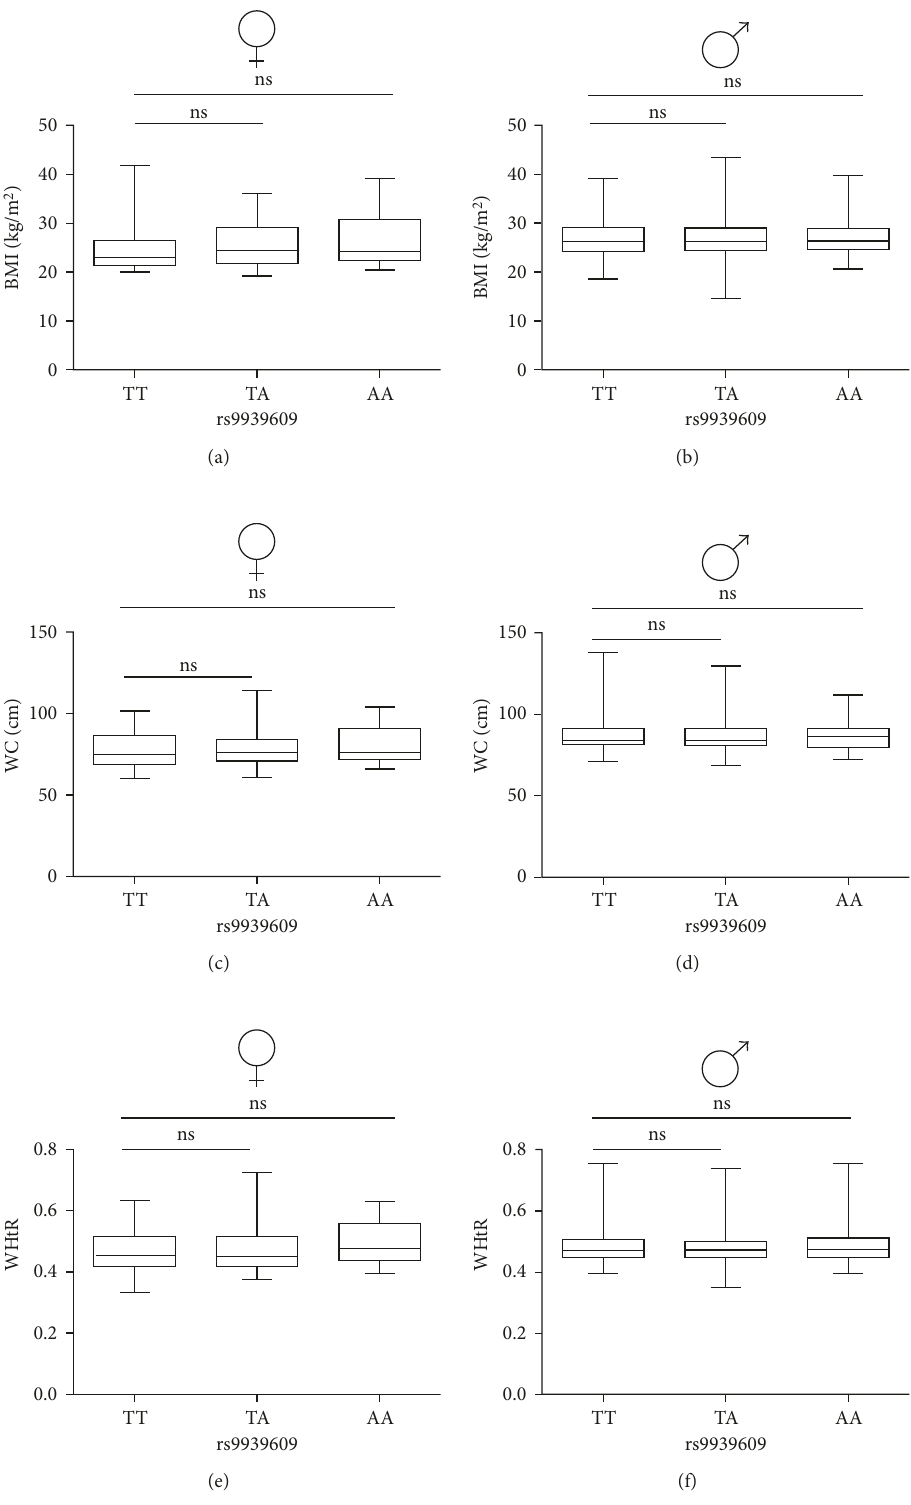
Figure 1: Box plots and analysis of the effect of FTO rs9939609 gene variant on obesity-related parameters. (a, b) Body mass index (BMI); (c, d) waist circumference (WC); (e, f) waist-to-height ratio (WHtR). (a, c, e) female; (b, d, f) male. Females: n � 107 (AA � 18, AT � 40, and TT � 49). Males: n � 421 (AA � 77, AT � 196, and TT � 148). The line within box represents the median, while the lower and upper box lines represent the interquartile range (1st and 3rd quartiles). The whiskers represent the minimum and maximum observations. Linear mixed models, adjusted for age and sex, were used to examine between-genotype differences. No significant differences were seen in obesity-related parameters between FTO rs9939609